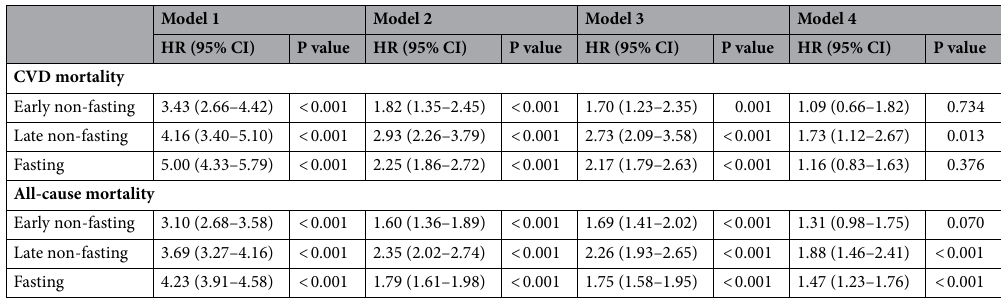
Table 2. Mortality risk associated with a 1-natural-log-unit increase in plasma glucose in 34,907 participants. CI, confidence interval; CVD, cardiovascular disease; HR, hazard ratio. Model 1: unadjusted. Model 2: adjusted for age, sex, and ethnicity. Model 3: adjusted for all the factors in Model 2 plus obesity, education, poverty-income ratio, survey period, physical activity, alcohol consumption, smoking status, self-reported hypertension, and self-reported hypercholesterolemia. Model 4: adjusted for all the factors in Model 3 plus natural log-transformed hemoglobin